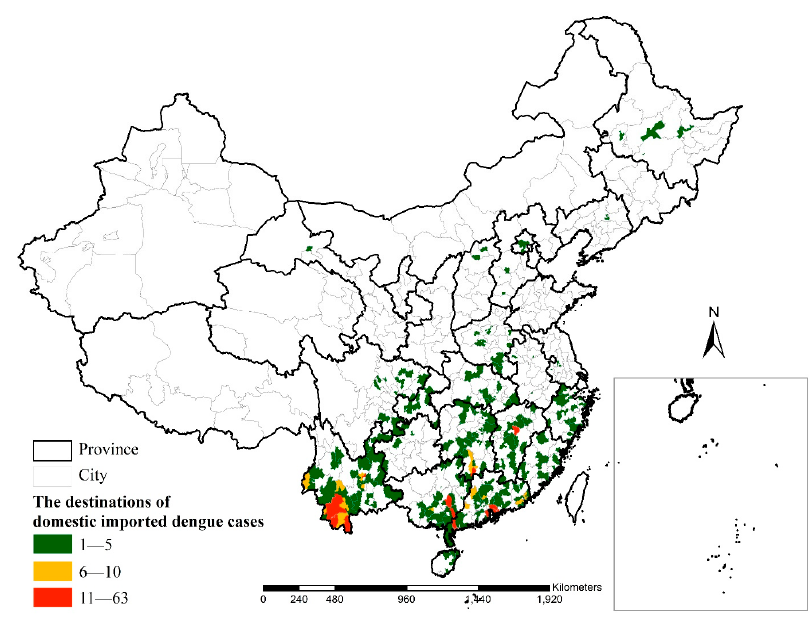
Figure 4. Spatial distribution of domestic imported dengue cases.